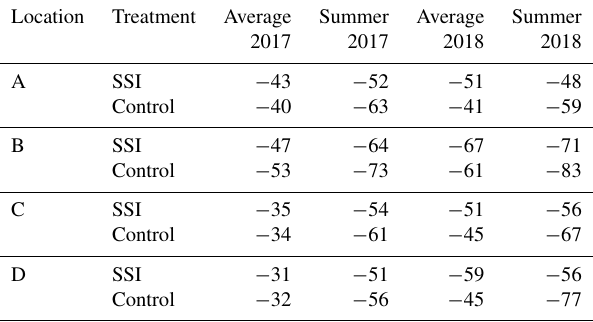
Table 2. Average groundwater table (cm from the surface level) during the measuring period per farm. Summer groundwater table ranges from April until October. Measured 1.5m from the SSI